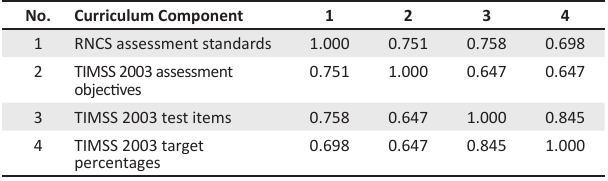
TABLE 10: Porter indices of alignment amongst the TIMSS components and the RNCS.